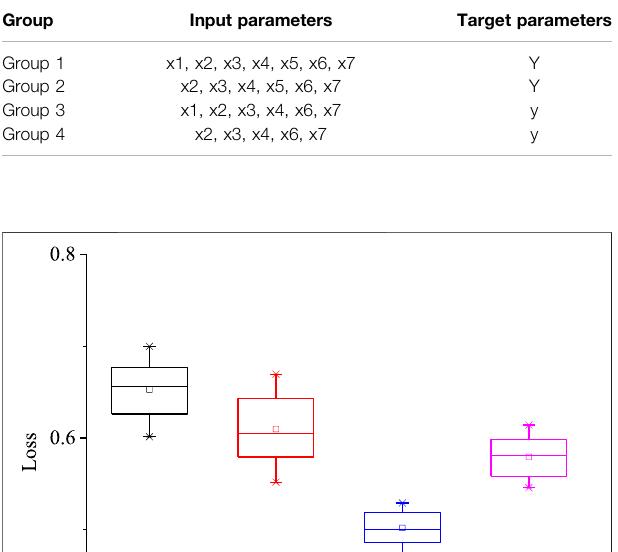
TABLE 4 | Combination of input and output parameters.